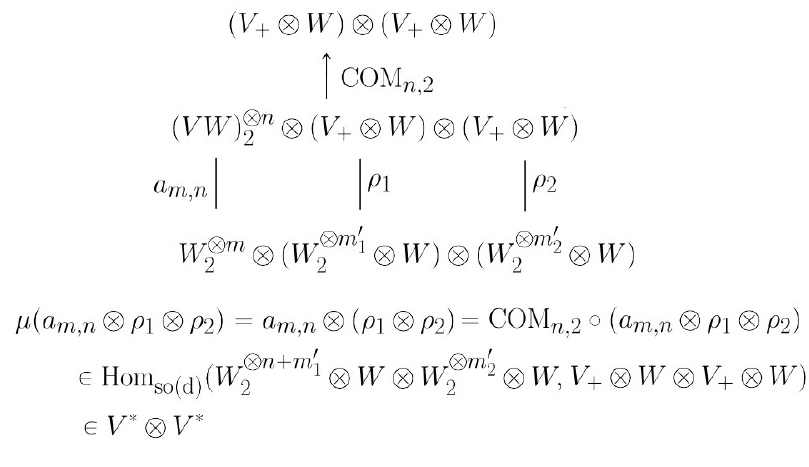
Figure 5 . De(cid:12)nition of U ? action on V ? (cid:10) V ?